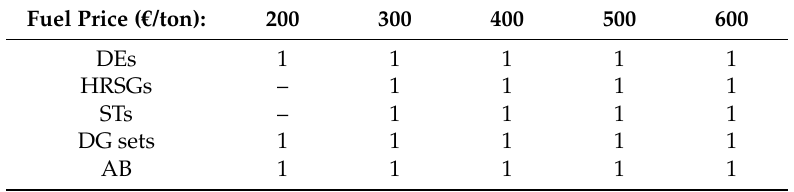
Table 34. Effect of fuel price on the optimal synthesis of the system for nominal freight rate. Fuel Price ( €